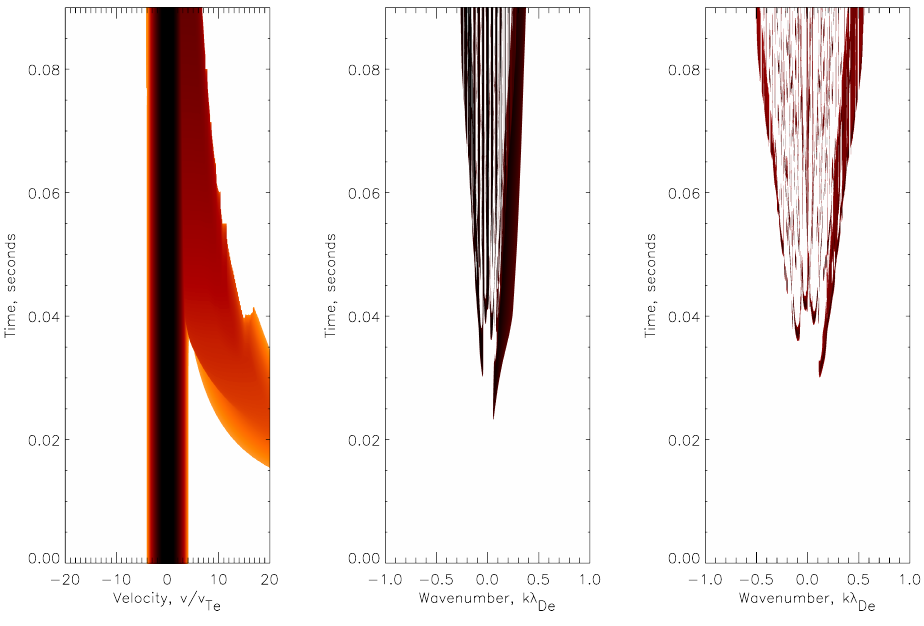
Fig. 11. Evolution of electron distribution function (left panel), Langmuir waves (middle panel) and ion-acoustic waves, (right panel) in time and velocity/wavenumber